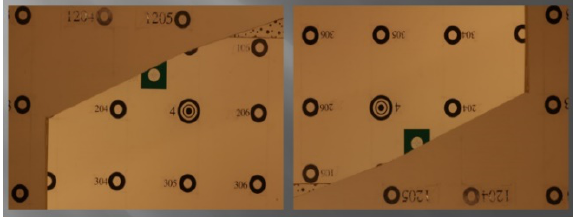
Figure 2. Photos of the test object with a long-focus